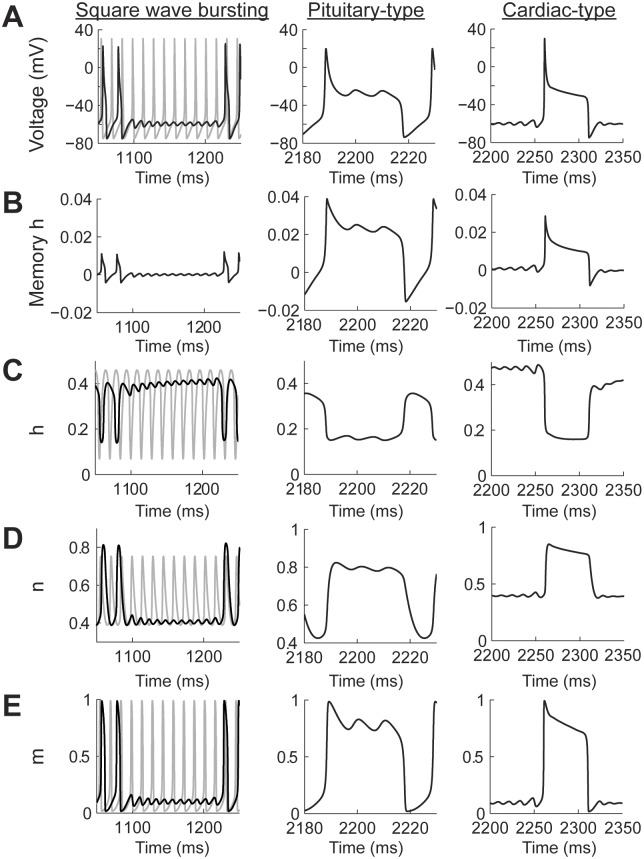
The contribution of the memory trace to square wave bursting and pseudo plateau potential spiking patterns in the Hodgkin-Huxley model with power-law behaving h gate.(A) Voltage traces for square wave bursting and two types of pseudo plateau potential (pituitary and cardiac types). The gray plot corresponds to the classic Hodgkin-Huxley model. (B-E) the temporal behavior of the h memory trace, and gating variables. The square wave bursting was generated with a fractional order derivative of η = 0.4 and the input current I = 10 nA; the Pituitary type was generated with η = 0.2 and I = 20 nA; and the cardiac type was generated with η = 0.2 and I = 9 nA.